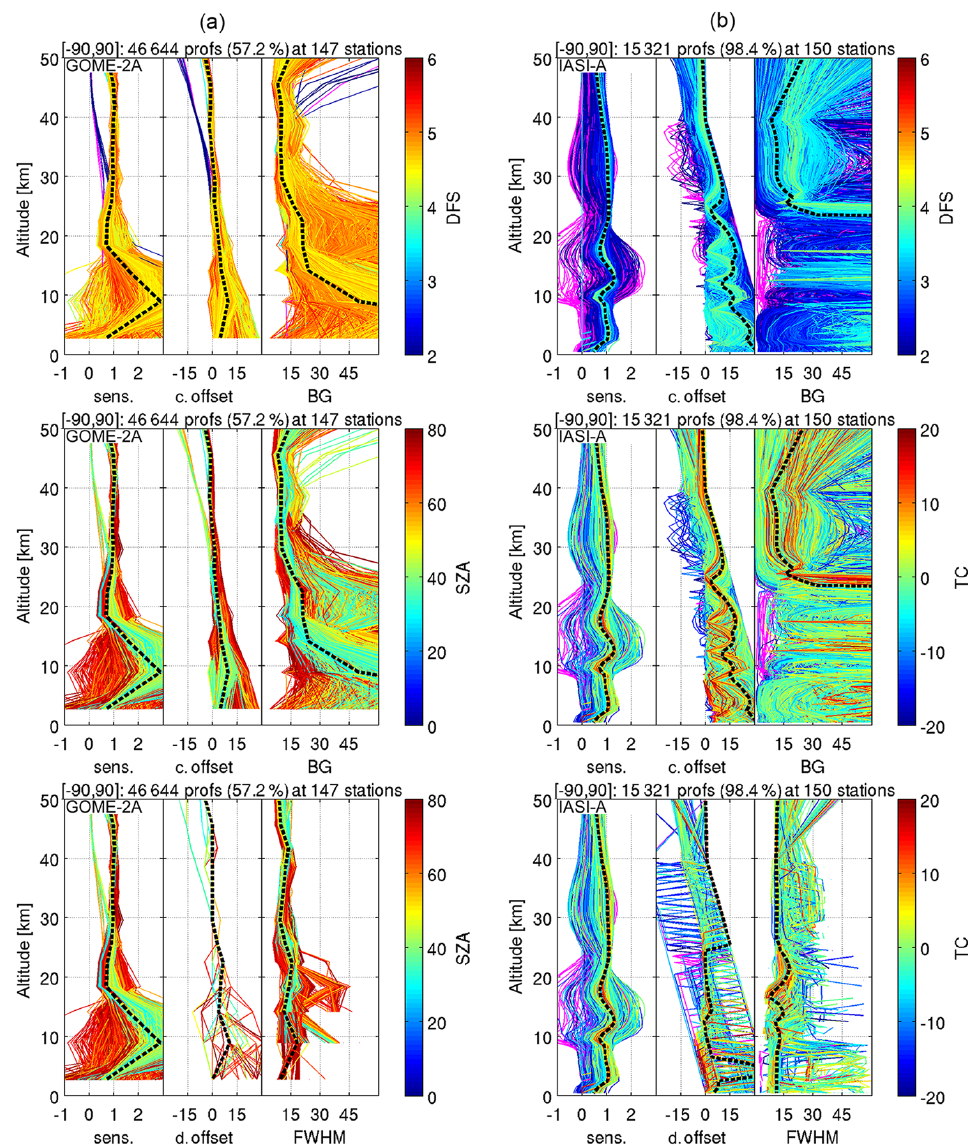
Figure 5. Global GOME-2A (a) and IASI-A (b) information content in terms of vertical sensitivity, retrieval offset (in kilometres), and averaging kernel width (in km) and their dependence on DFS, SZA, or thermal contrast (TC). Black dashed lines represent median values, while out-of-range profiles are plotted in magenta. Different measures are used for the offset and kernel width in the second and third rows, which include the centroid offset (c. offset) and Backus–Gilbert spread (BG) and the direct offset (d. offset) and FWHM, respectively. Plot titles provide the absolute and relative amounts of profiles after screening and the number of ground-based overpass